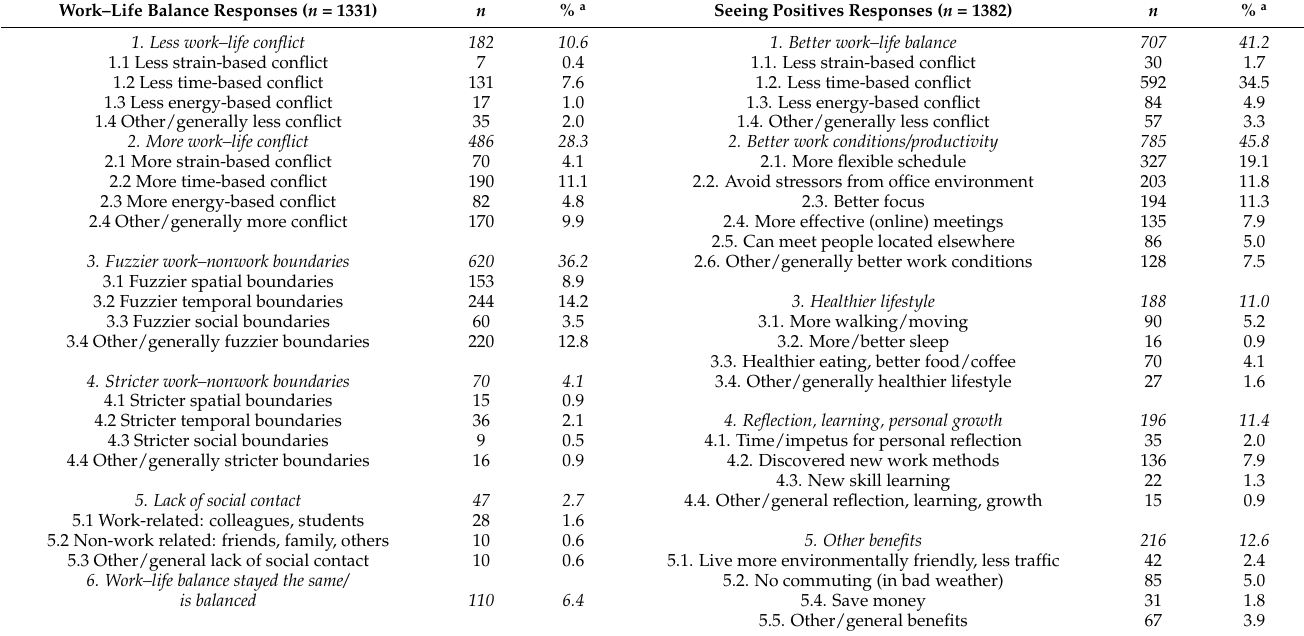
Table 1. Codes for work–life boundaries and seeing